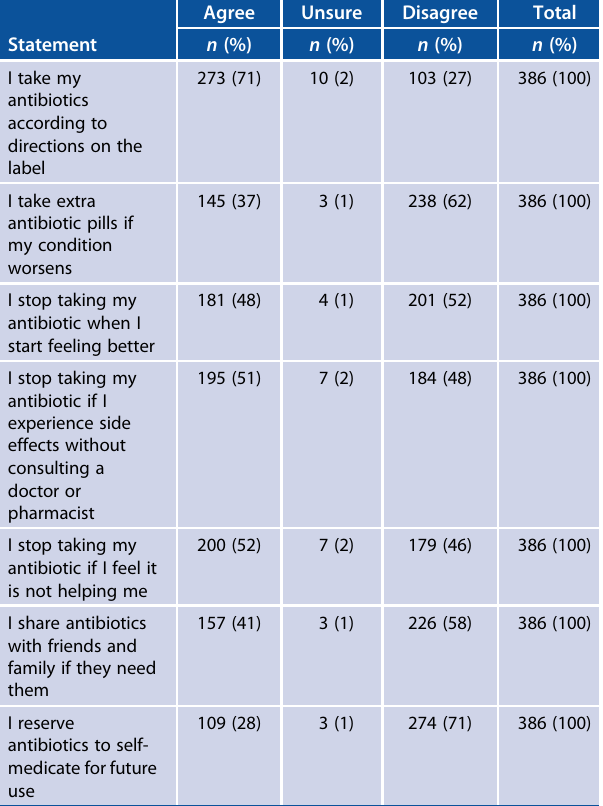
Table 6: Patients ’ practices regarding antibiotic use at Prince Mshiyeni Memorial Hospital 2017